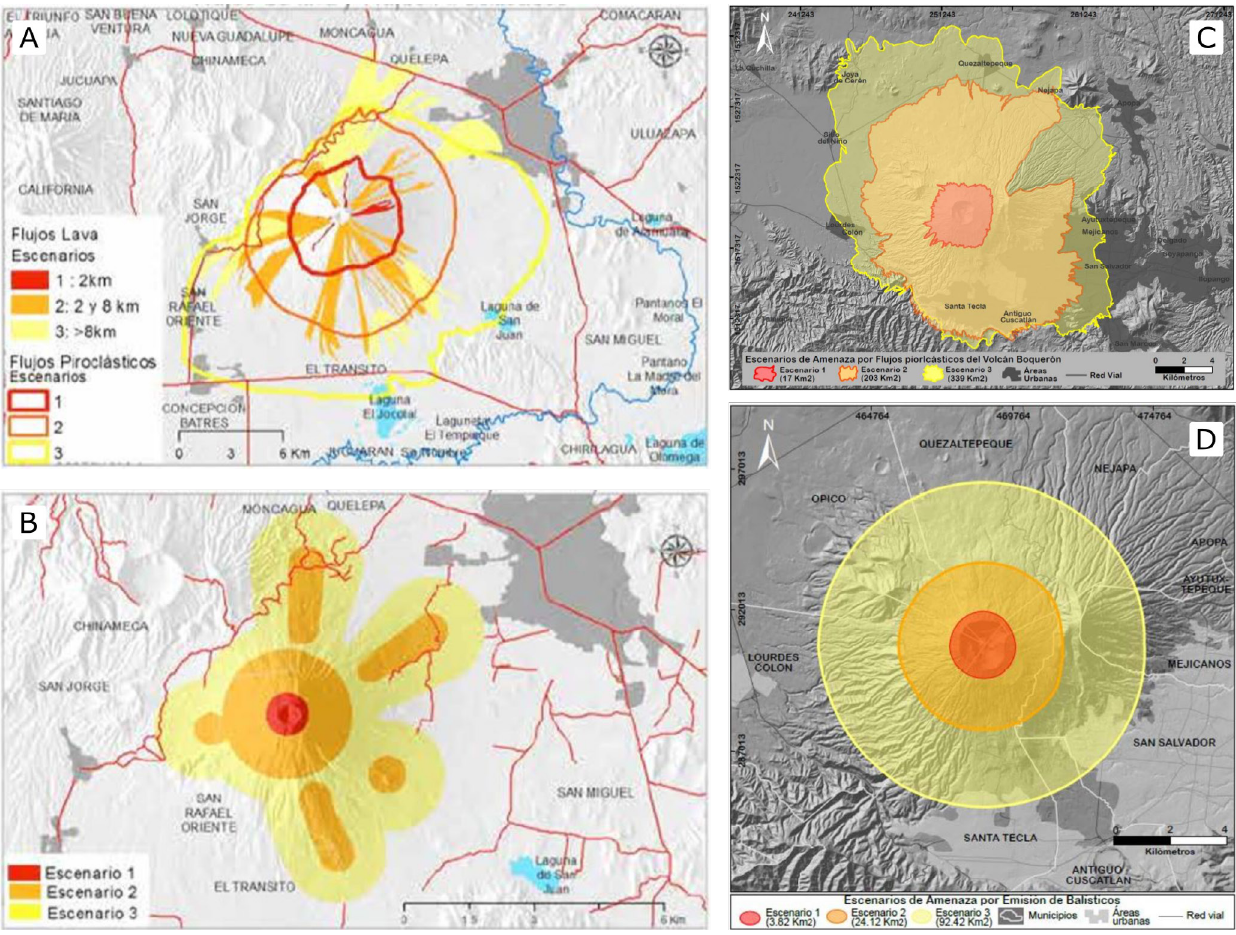
Figure 3: Example of hazard maps for Salvadoran volcanoes according to three different scenarios (small erup- tions with high probability in red, moderate eruptions with intermediate probability in orange, and large eruptions with low probability in yellow). [A] Map representing pyroclastic and lava flows hazards for San Miguel volcano [Escobar et al. 2004]. [B] Emission of ballistics hazard map for San Miguel volcano [Escobar et al. 2004]. [C] Py- roclastic flow hazard map for San Salvador volcano (also referred as Volcán Boquerón as in the figure, [Ferrés 2014]). [D] Emission of ballistics hazard map for San Salvador volcano [Ferrés 2014]. struments [MARN